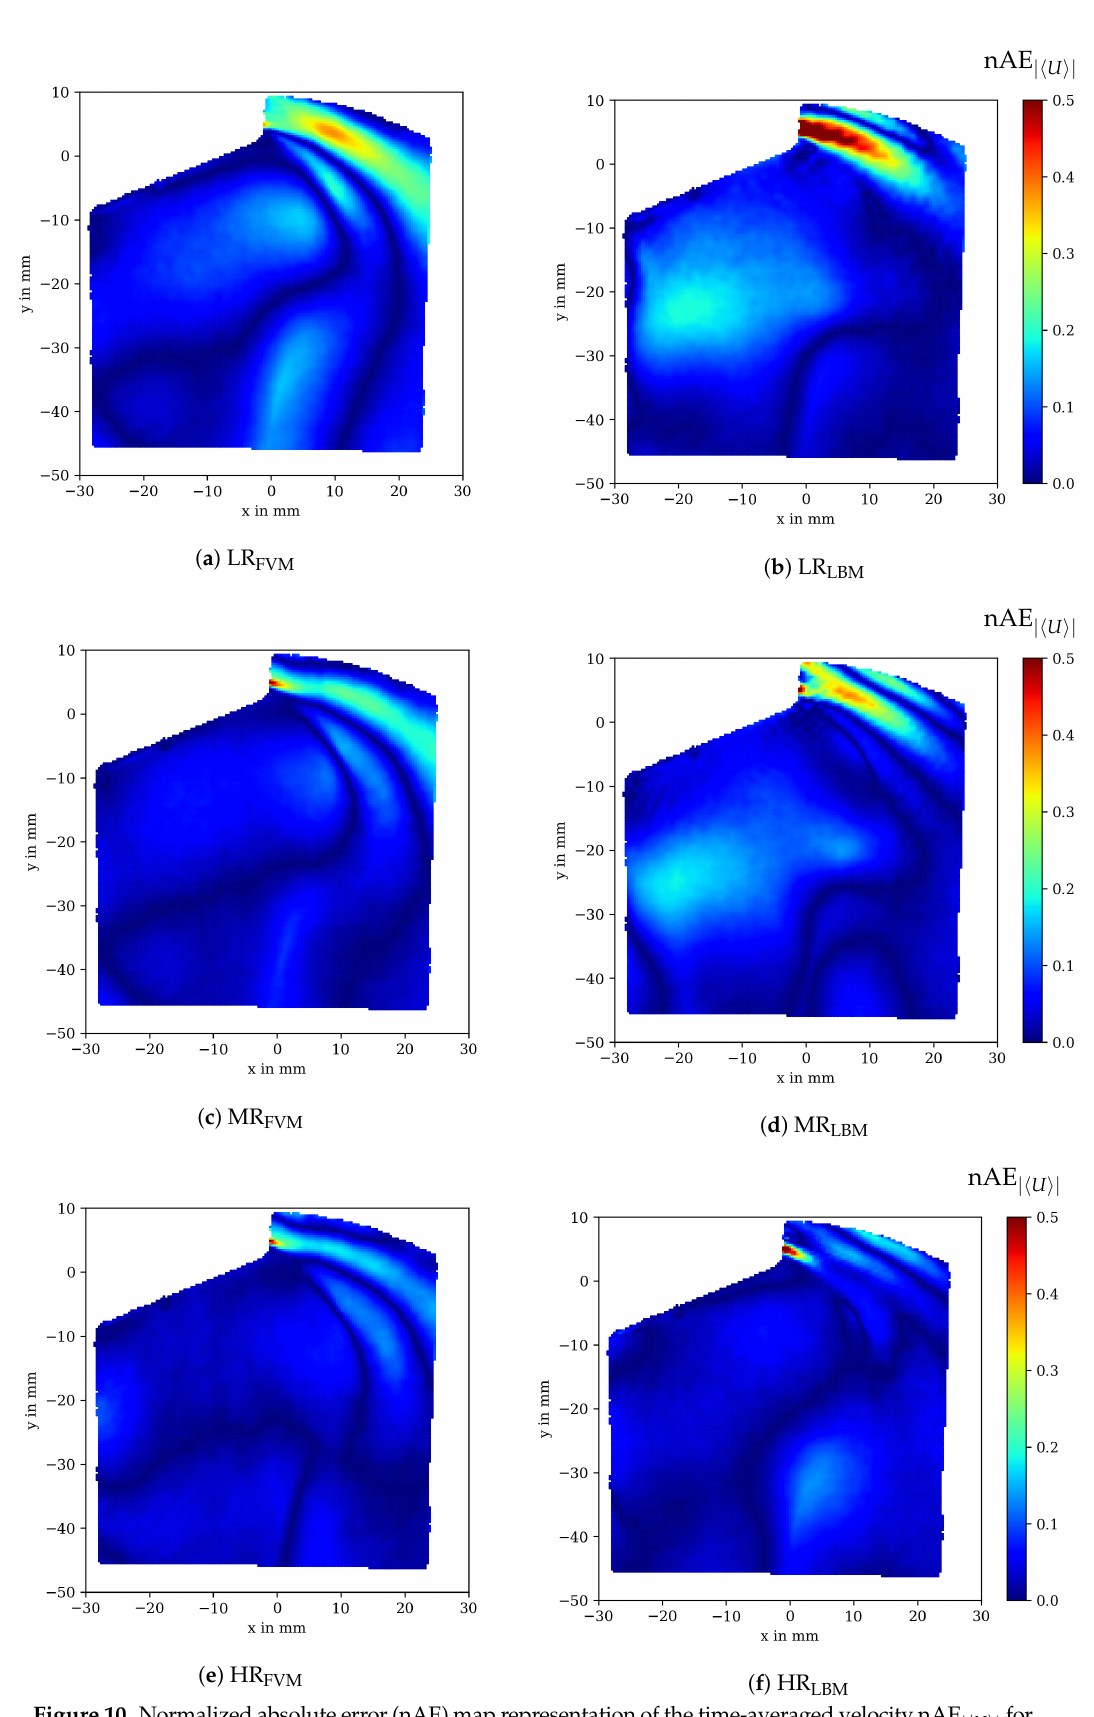
Figure 10. Normalized absolute error (nAE) map representation of the time-averaged velocity nAE in-cylinder flow against PIV data for OpenFOAM (left) and OpenLB (right) at different grid